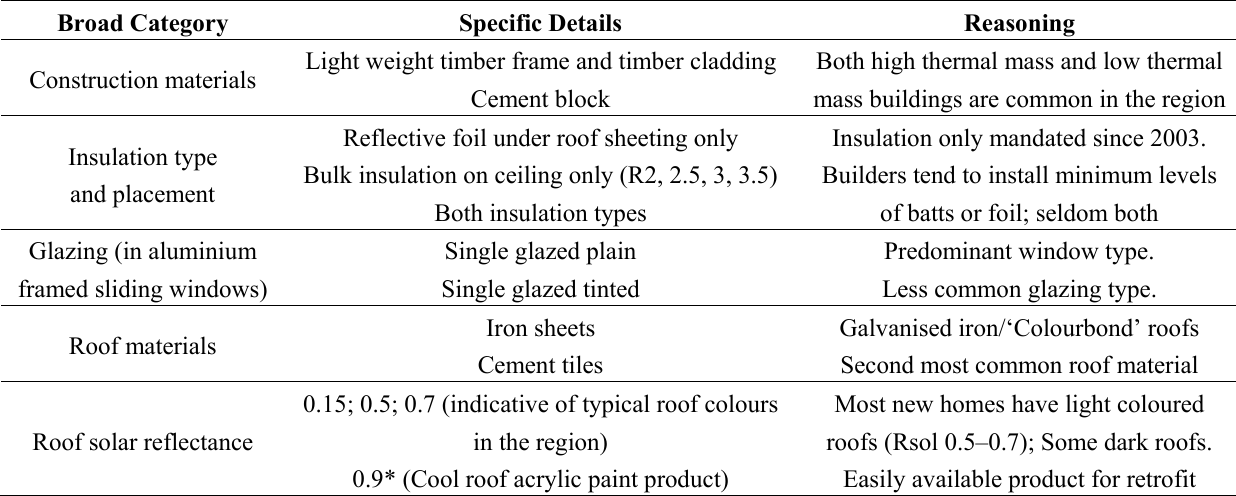
Table 4. Common construction materials used in simulations.